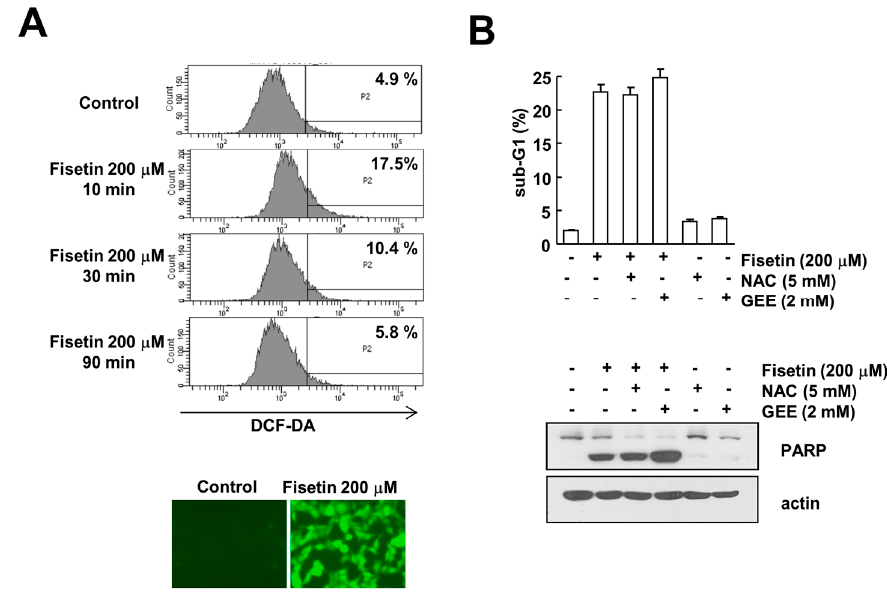
Figure 6. The effect of ROS production on fisetin-induced apoptosis. ( A ) Caki cells were treated with 200 µ M fisetin for the indicated time periods (upper panel) or 10 min (lower panel), and were loaded with H 2 DCF-DA fluorescent dye. H 2 DCF-DA fluorescence intensity was detected by flow cytometry (upper panel) and fluorescence microscopy (lower panel); ( B ) Caki cells were pretreated with 5 mM N -acetylcystine (NAC) and 2 mM glutathione ethyl ester (GEE) for 30 min, and then stimulated with 200 µ M fisetin for 24 h. The sub-G1 fraction was measured by flow cytometry as an indicator of the level of apoptosis. The protein expression levels of PARP and actin were determined by western blotting; the values in ( B ) represent the mean ± SD from three independent samples.